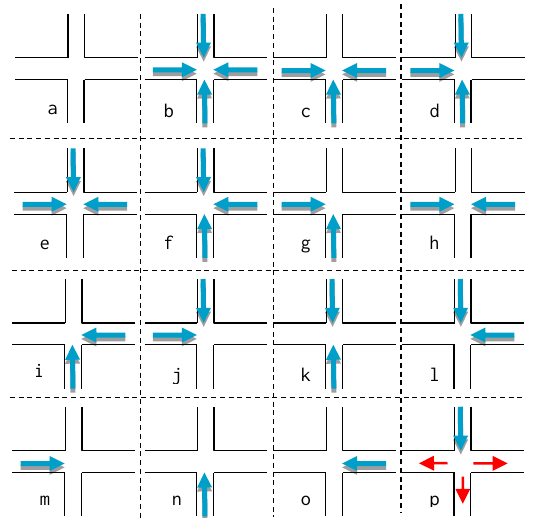
Figure 9. Blue arrows symbolize clusters of stop events which come from vehicles moving along directions indicated by the arrows. They are considered as valid combinations of clusters that contribute to junction discovery. These clusters are discovered at step 1 of the method described in this